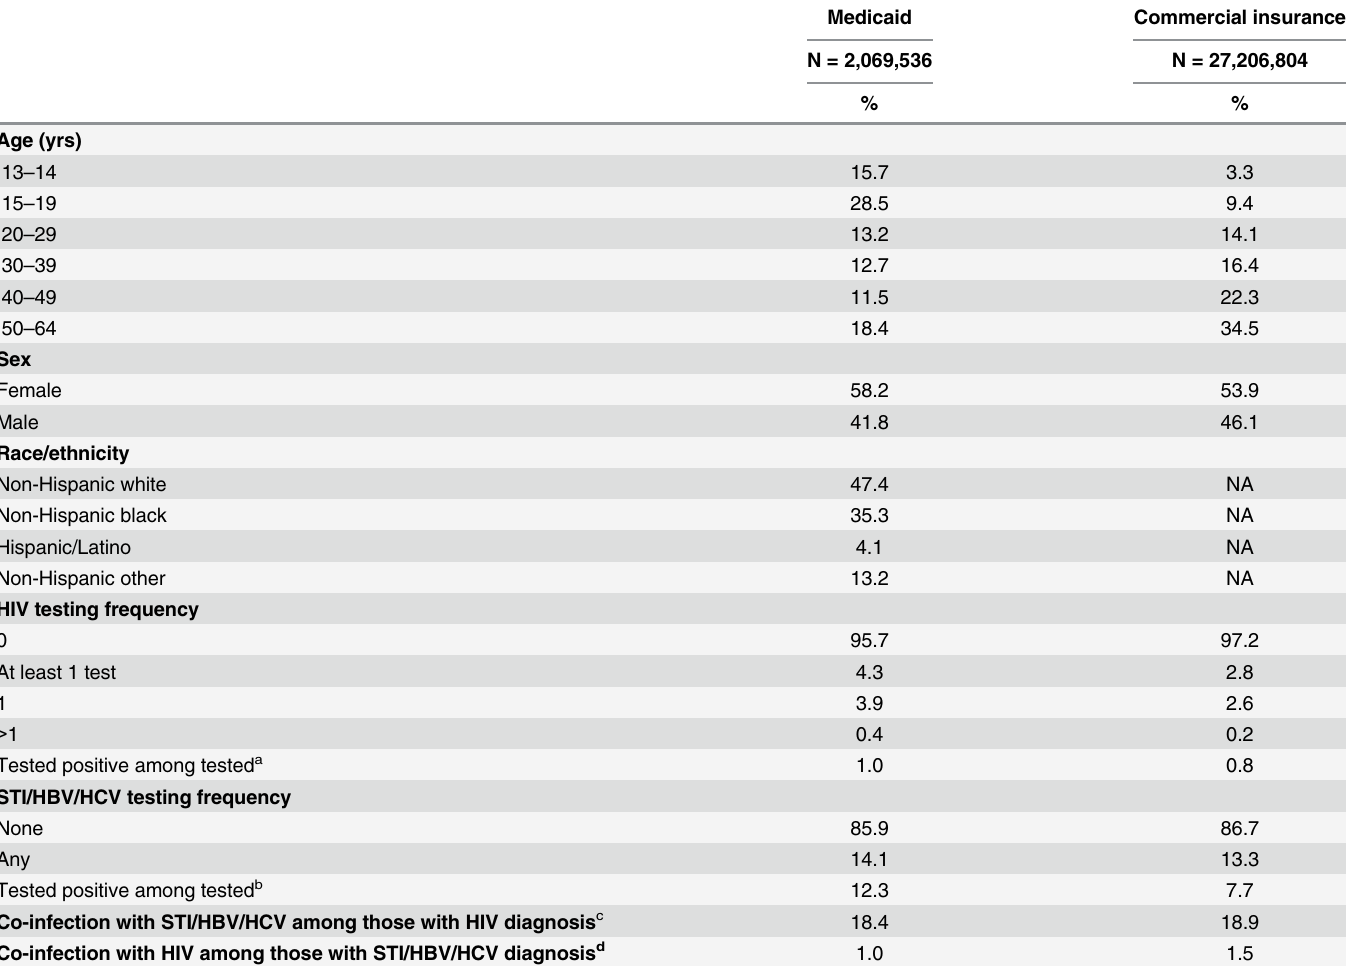
Table 2. Demographics and HIV testing by type of health plan, Medicaid and commercial insurance, 2012.